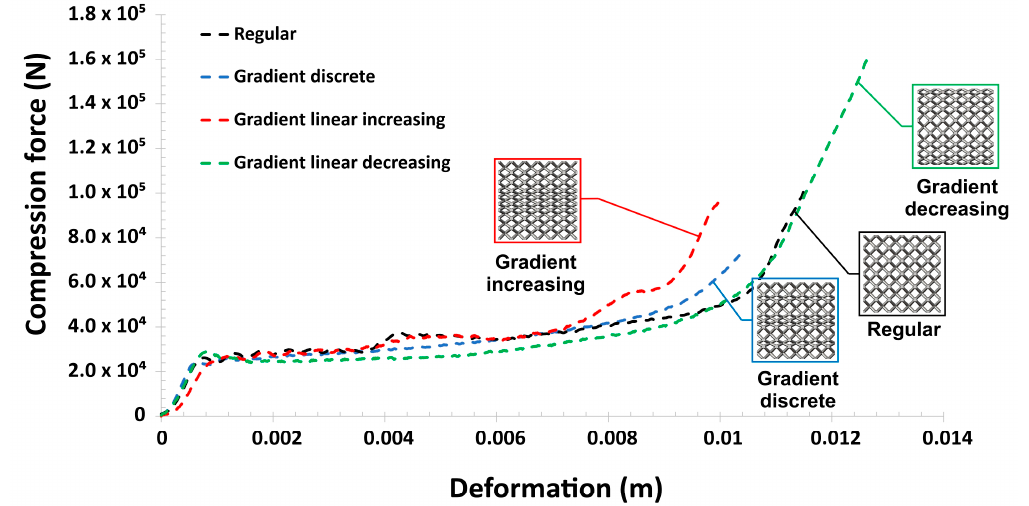
Figure 16. Results of compression tests (deformation force versus displacement) conducted under impact loading conditions.